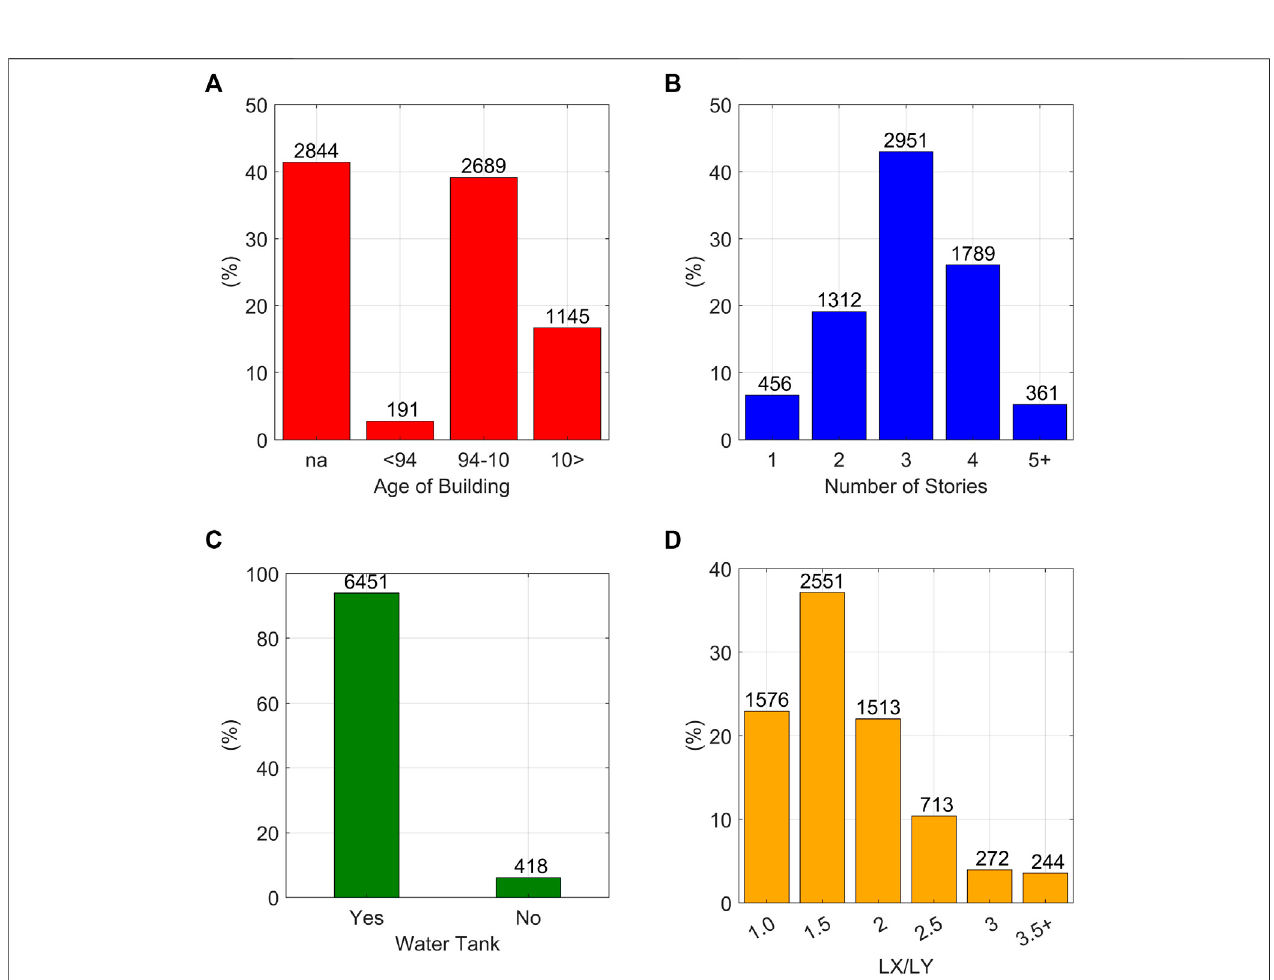
FIGURE11| Barchartsof (A) ageofbuildingsinthedatabase, (B) numberofstoreys, (C) thepresenceofrooftanks, (D) in-planratiosforthebuildingsascollected from GIS (LX/LY).